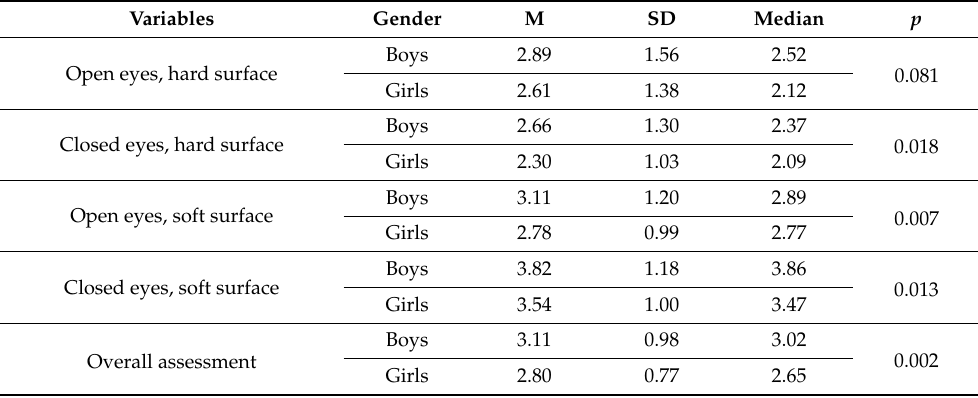
Table 2. Results of the trials for the Clinical Test of Sensory Integration and